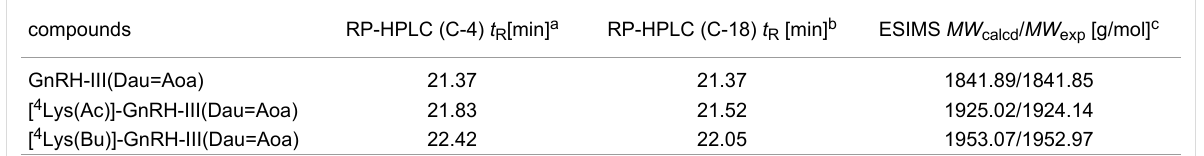
Table 1: Analytical characteristics of Dau–GnRH-III conjugates